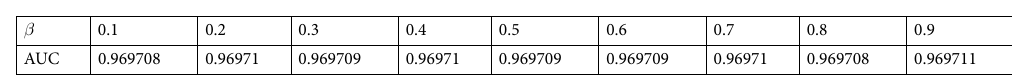
Table 2. The AUC under different beta values.